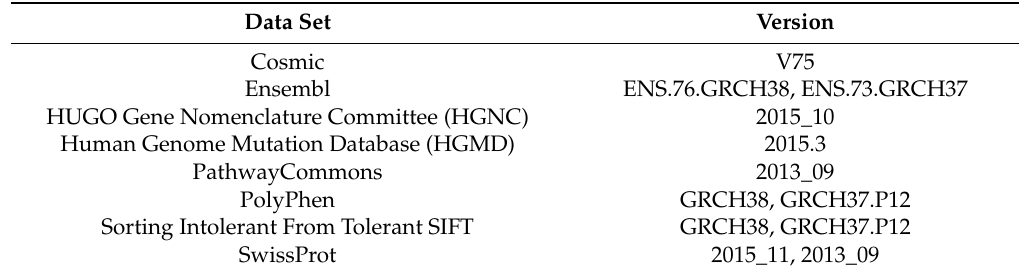
Table 3. Mayo Oracle TRC reference data.